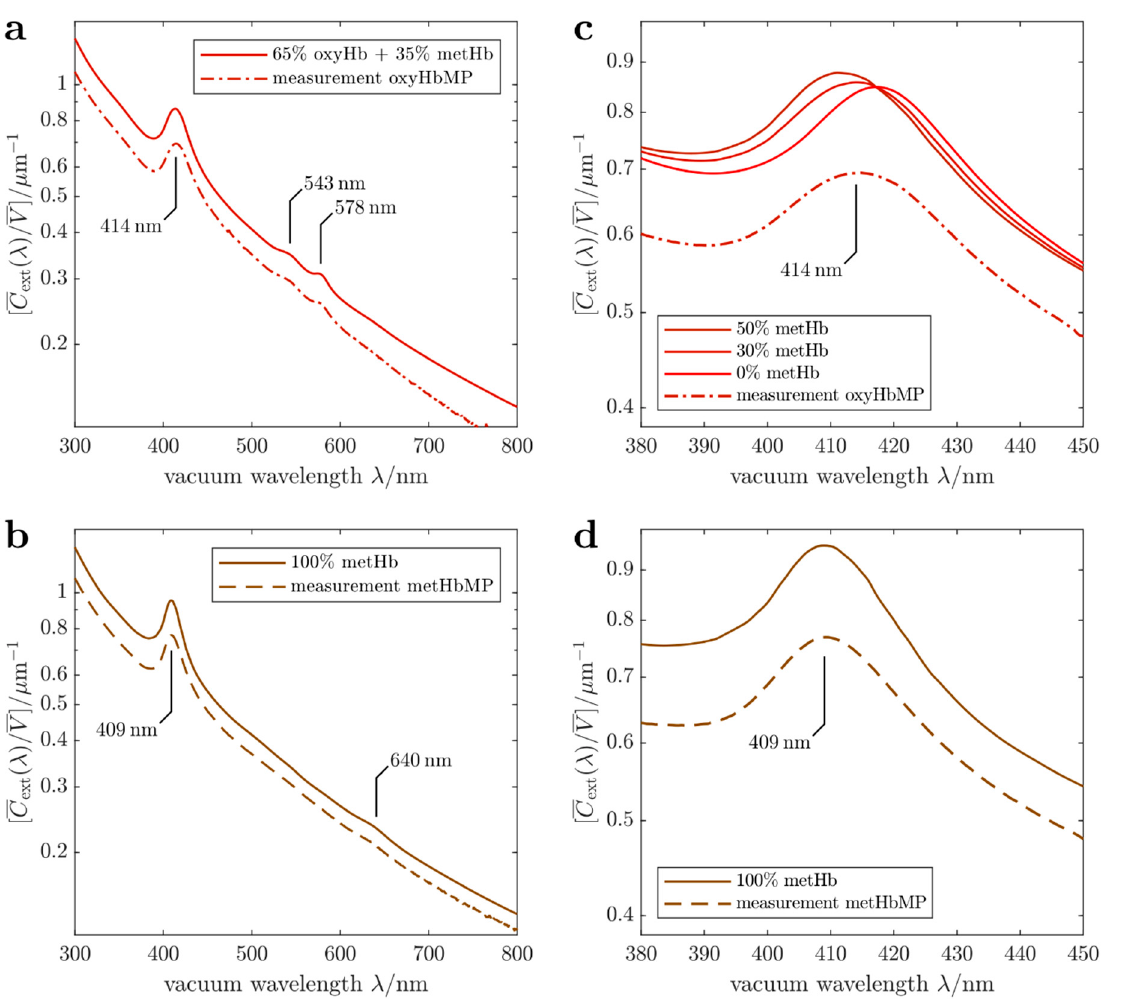
Figure 2. Results of spectral extinction measurements and simulations. ( a ) Volume-specific spectral extinction cross sections measured for oxyHbMP (dot-dashed red line) and calculated (red line) using 35% fraction of metHb and 65% oxyHb. ( b ) Volume-specific spectral extinction cross sections measured for metHbMP (dashed brown line) and calculated for 100% metHbMP (brown line). ( c ) Comparison of the measured spectral cross section in the Soret band and cross sections calculated for various metHb fractions. ( d ) Reduced wavelength range to show the Soret band of the measured and calculated extinction spectra.